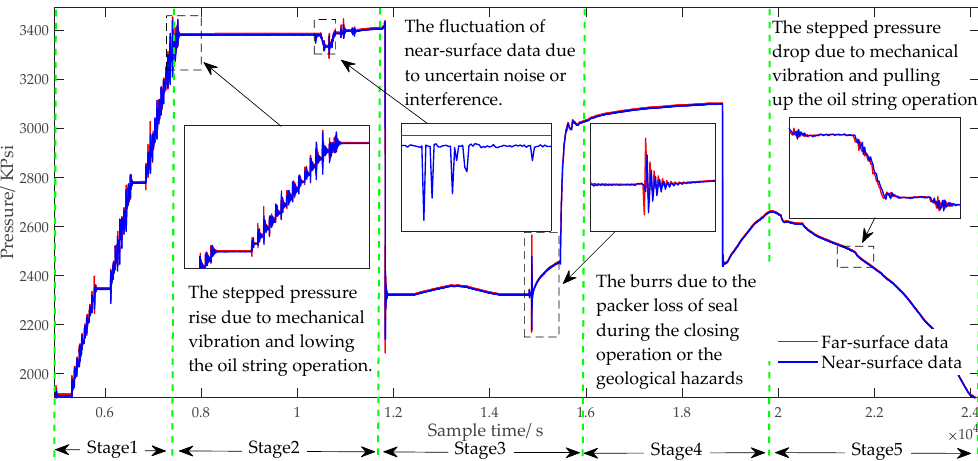
Figure 1. Diagram of oil well-testing data characteristics analysis. Five stages in the complete well-testing process are: Stage1: Lowering the oil string. Stage 2: Waiting stage. Stage 3: Well opening. Stage 4: Well closing. Stage 5: Pulling up the oil string.